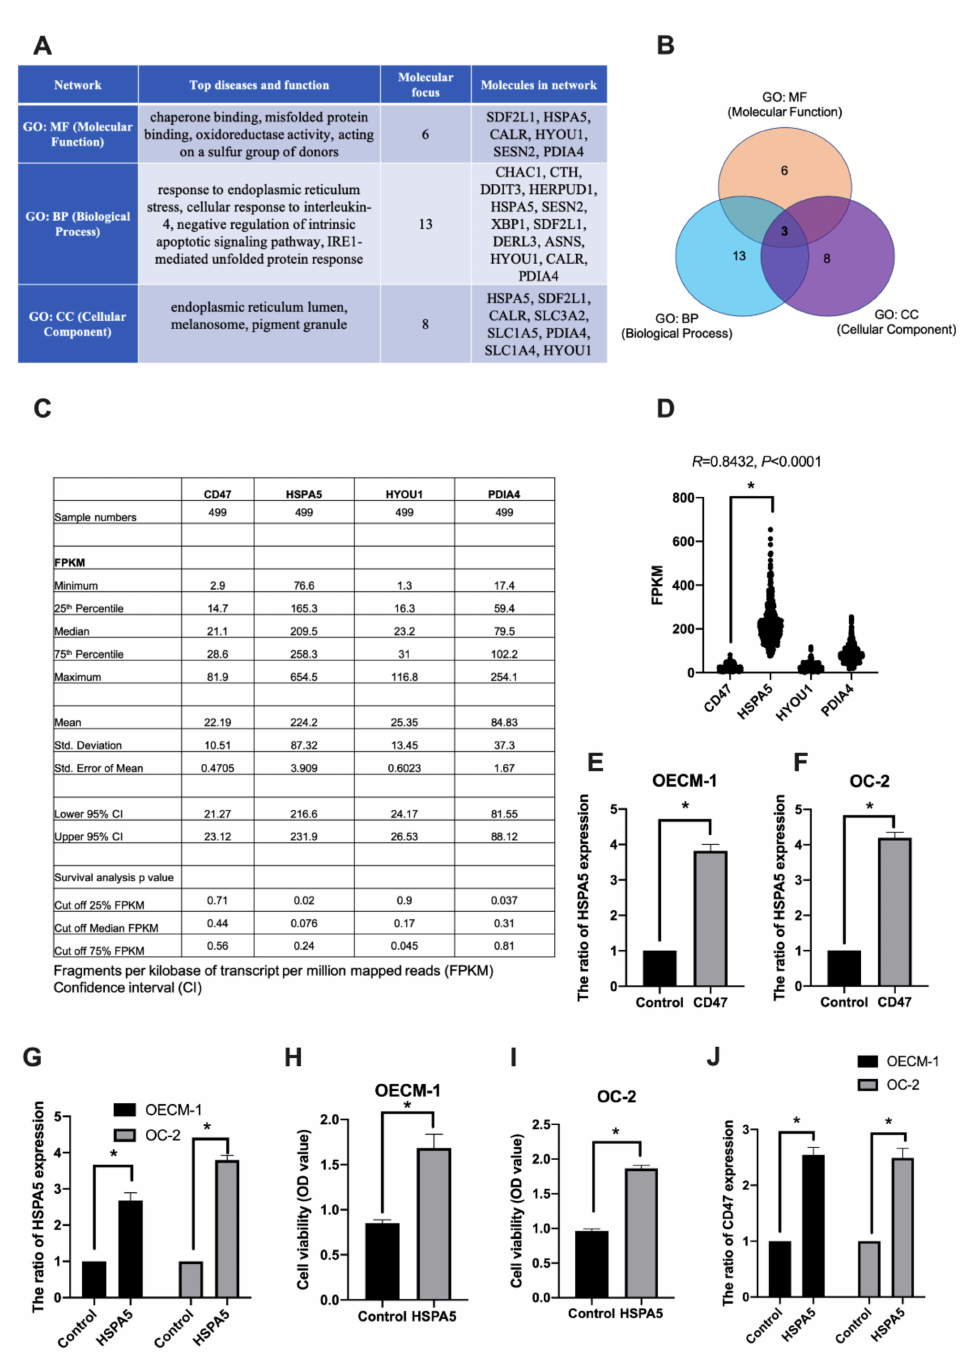
Figure 4. The biofunction pathway analysis of the differentially expressed genes regulated by CD47-overexpression in oral cancer cells. ( A ) The network analysis report of upregulated genes by CD47-overexpression in OECM-1 and OC-2 cells. Molecular focus gene was involved in top diseases and function. ( B ) Three identified genes, HSPA5, HYOU1, and PDIA4, were found to be involved in molecular functions, biological processes, and cellular components in OSCC. ( C , D ) CD47, HSPA5, HYOU1, and PDIA4 gene expression and survival was analyzed using the HPA database. Cut off FPKM of 25%, 50%, and 75% were used to find the survival rate, respectively. R; correlation coefficient; two-tailed Student’s t -test. ( E , F ) The expression of HSPA5 was examined in CD47-overexpressing OECM-1 and OC-2 cells using qPCR. ( G , J ) HSPA5 and CD47 gene expression was analyzed by qPCR and ( H , I ) cell growth was analyzed by CCK-8 assay. The data are presented as the mean ± SD of three experiments. * p < 0.05 vs. empty control; two-tailed Student’s t